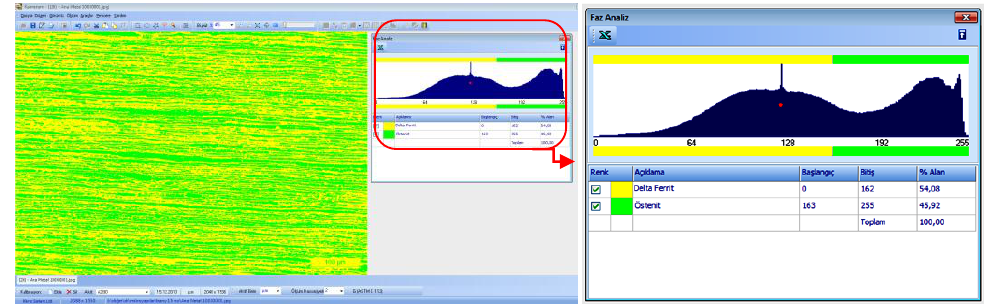
Figure 6. Image analysis of raw (unwelded) stainless steels.